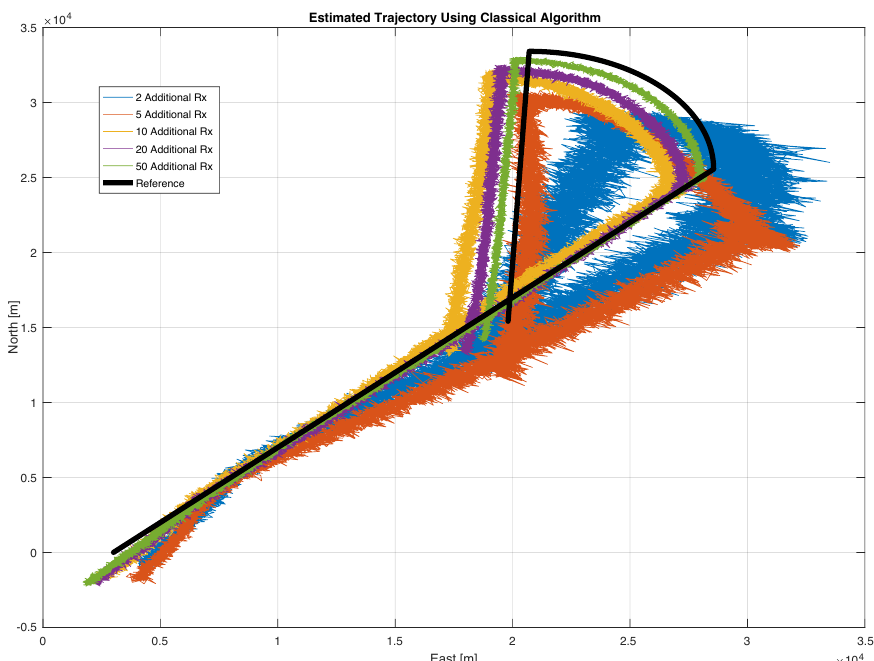
Figure 12. Trajectory of the simulated target (bold black line) and trajectories estimated with the traditional TDOA algorithm (different colours represent estimation of the trajectory carried out with a different number of additional low-cost receivers: from 2 to